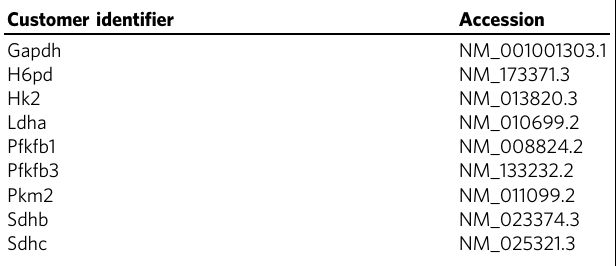
Table 2 nCounter metabolic custom